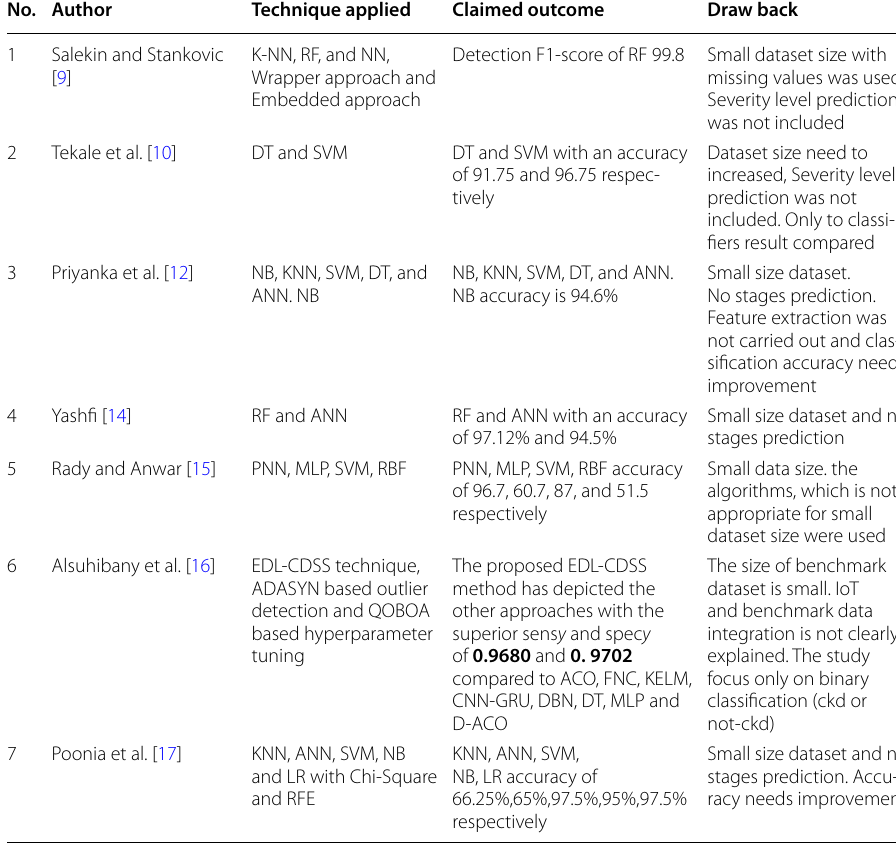
Table 1 Summary of some related